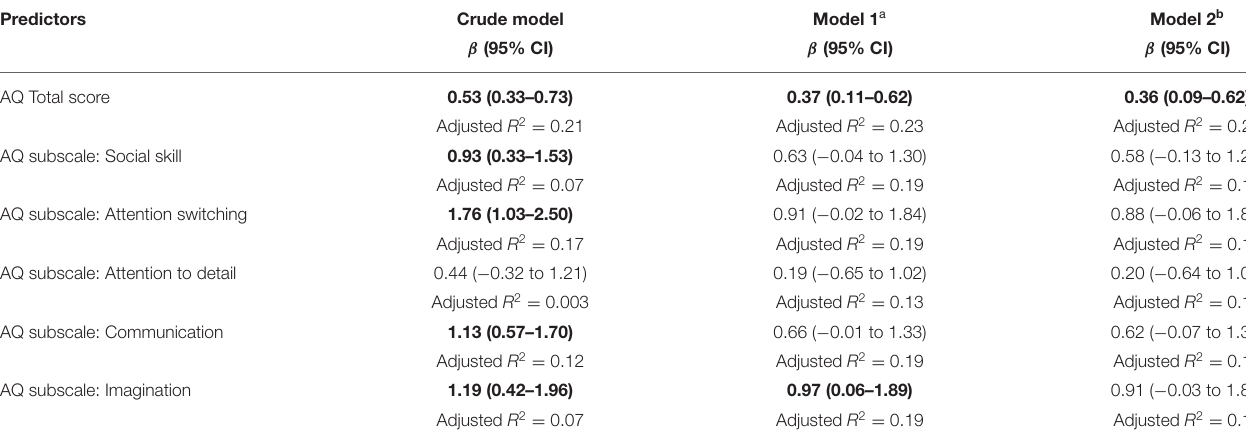
TABLE 2 | Association between AQ Total score and each sub-scale score and Y-BOCS.